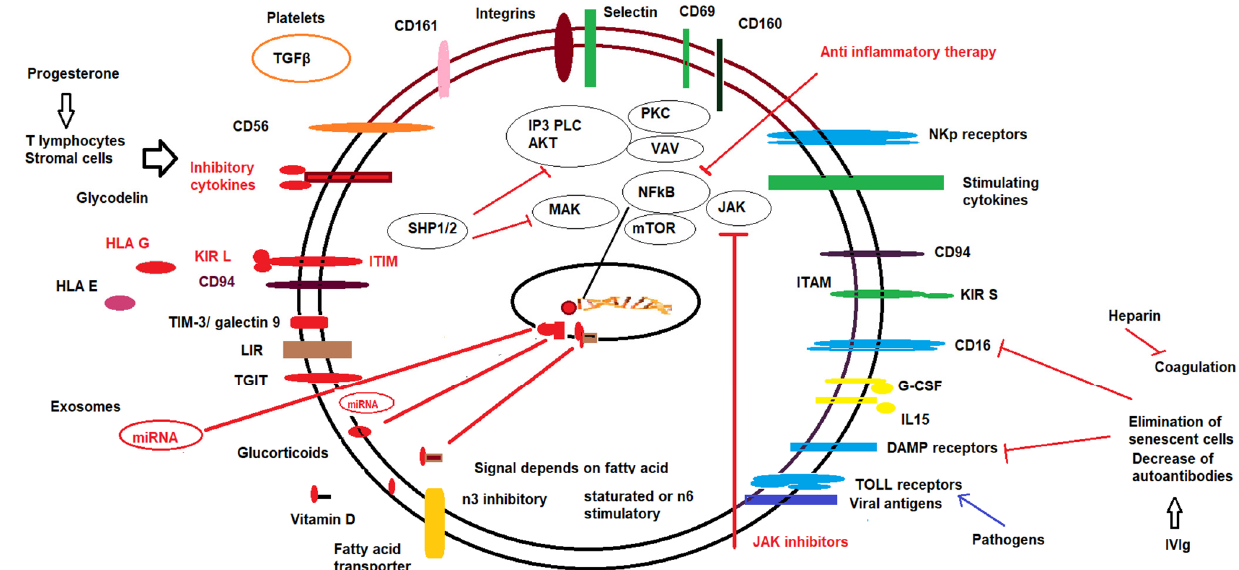
Figure 1. This figure summarizes the general aspects discussed in the review. Some of the most relevant receptors in human NK cells are represented along with the mechanism of the different therapies reviewed. The inhibitory effects are depicted in red, and the activating effects in blue. The receptors described in yellow represent an effect that can induce activation or inhibition. In the case of fatty acids, the effect encountered depends on the type of fatty acid, and in the case of the cytokines, G-CSF and IL-15, it depends on the NK cell type.